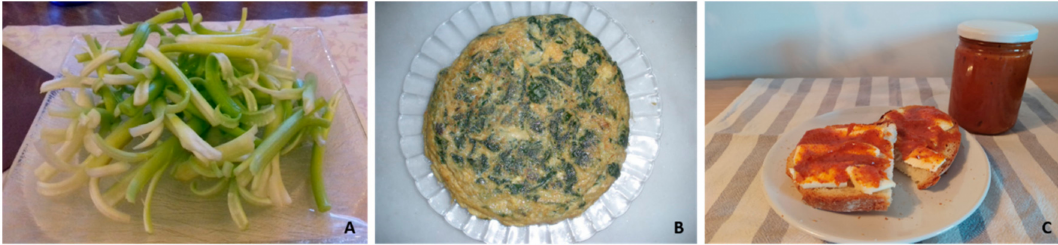
Figure 6. Examples of wild food plants prepared for consumption. ( A ) Molopospermum peloponnesiacum in salad; ( B ) Chenopodium bonus-henricus in omelette; ( C ) Arbutus unedo preserved in